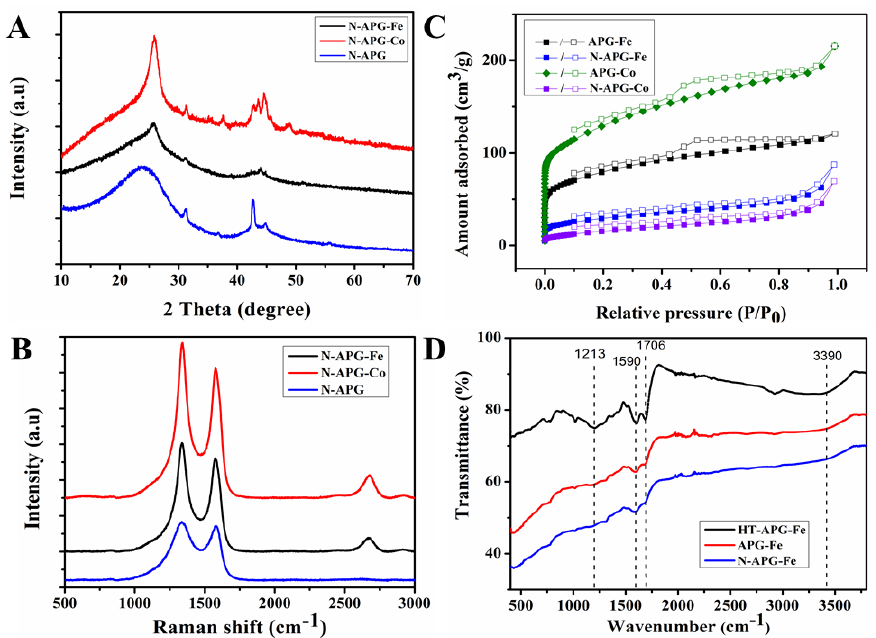
Figure 3. ( A ) XRD spectrum of N-APG, N-APG-Fe, and N-APG-Co, ( B ) Raman spectrum of N-APG, N-APG-Fe, and N-APG-Co, ( C ) N 2 adsorption/desorption isotherm of APG-Fe, N-APG-Fe, N-APG-